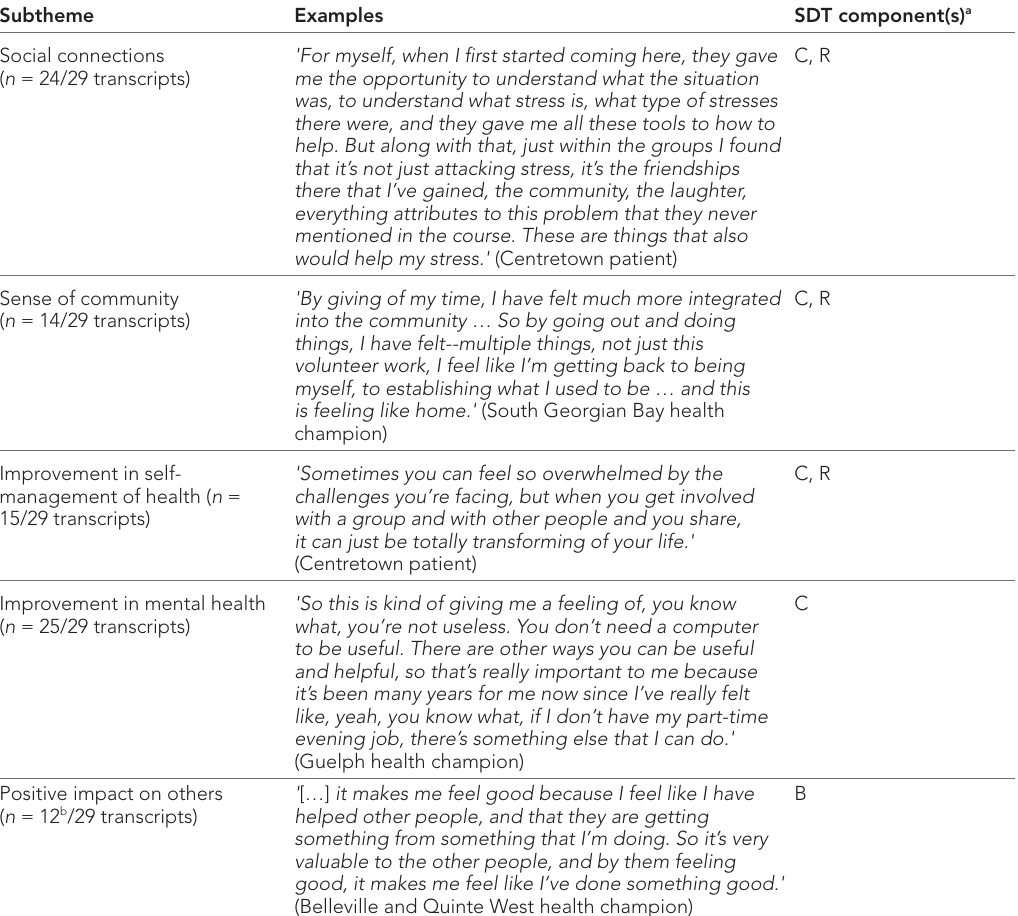
Table 4 Outcomes and relevance to self- determination theory components ( n = 25/29 transcripts) Subtheme Examples SDT component(s) a Social connections ( n = 24/29